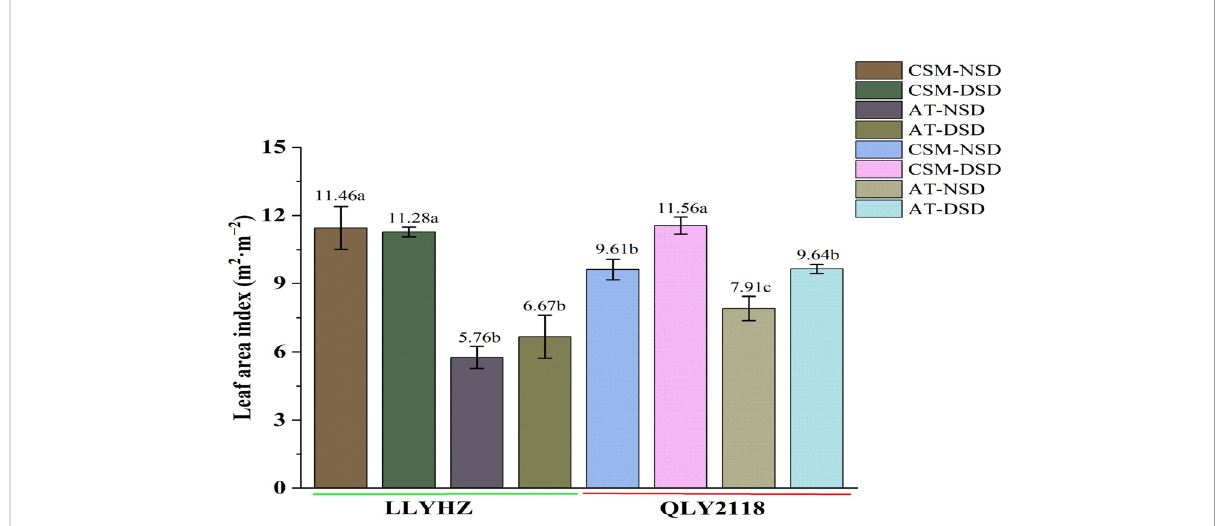
FIGURE 2 Leaf area index of two rice cultivars in the different treatments at the heading stage. Error bars indicate the SD of three biological replicates. Bars with different lowercase letters are signi fi cantly different (LSD test, p < 0.05). LLYHZ, Longliangyou Huazhan; QLY2118, Quanliangyou 2118; NSD, normal sowing date; DSD, delayed sowing date; CSM, carpet seedling mechanical transplantation; MT, manual transplanting; SD, standard